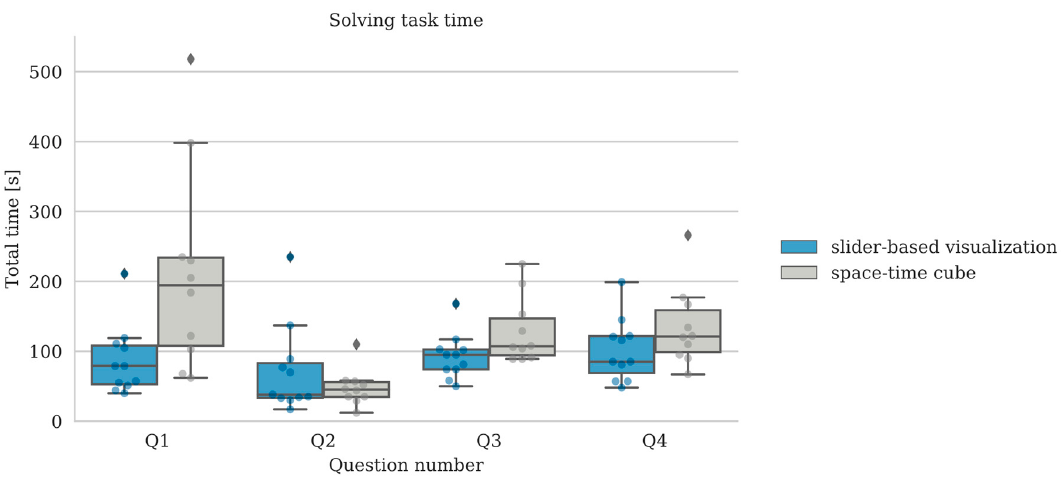
Figure 8. Solving task time for tested applications: the slider-based visualization and the space–time cube.